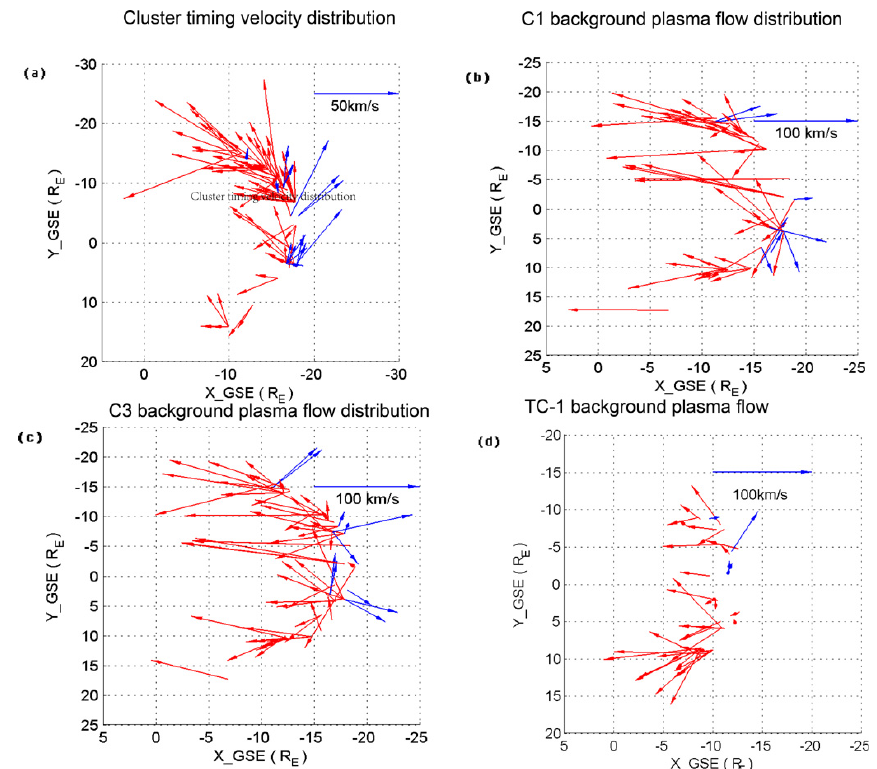
Fig. 8. (a) Distribution of timing velocities in X-Y plane of magnetic holes observed by Cluster. (b) The distribution of background plasma flow velocities observed by C1 in X-Y plane. (c) The distribution of background plasma flow velocities observed by C4 in X-Y plane. (d) Background plasma flow velocity distribution of magnetic holes observed by TC-1 in X-Y plane. The red lines represent magnetic holes propagating towards the Earth. The blue lines represent magnetic holes propagating